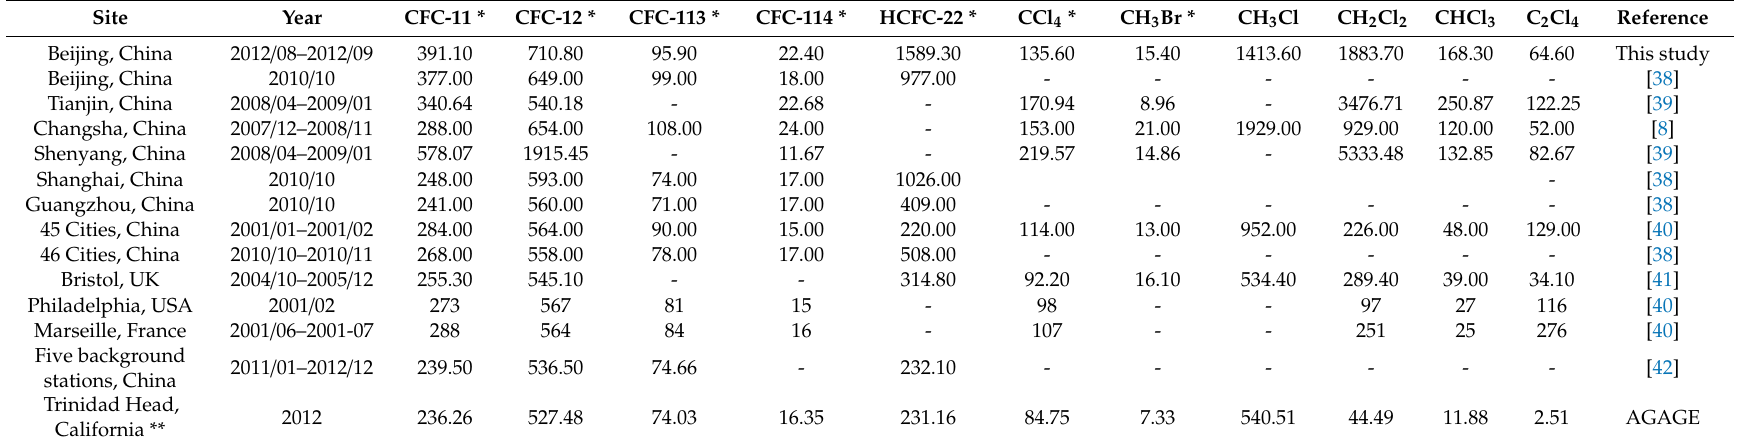
Table 2. Comparisons of concentrations of 11 volatile halogenated hydrocarbons (VHHs) in the study area against their global background levels from the Advanced Global Atmospheric Gases Experiment (AGAGE) and levels from other